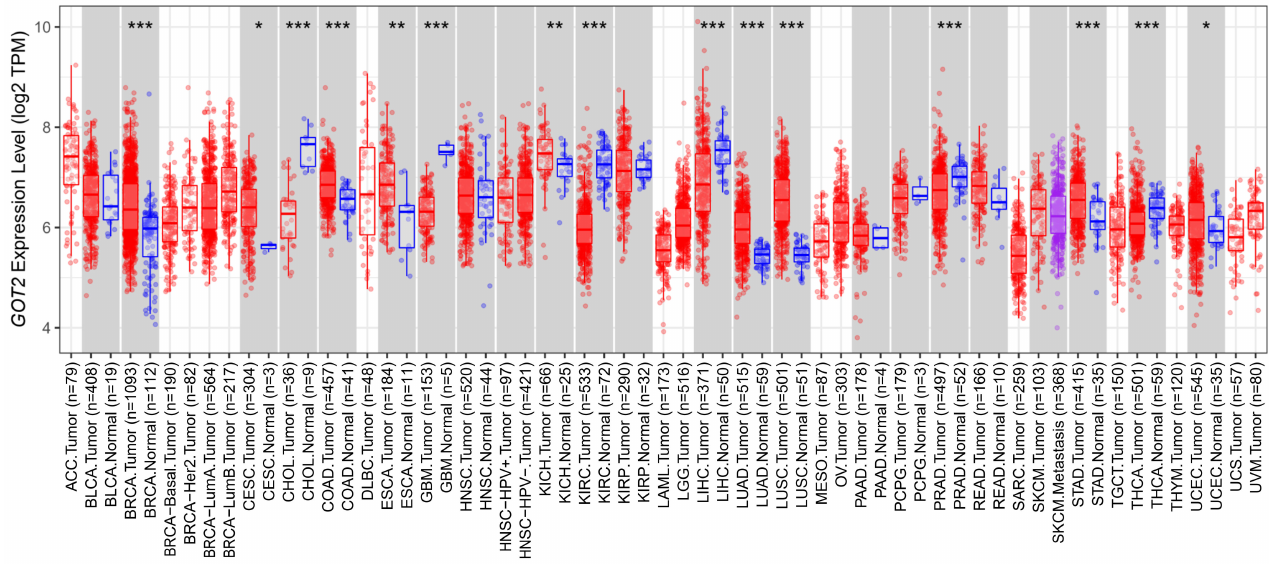
Figure 1. GOT2 expression levels in pan-cancer (TCGA dataset). The box plot comparing specific GOT2 expression in tumor samples (red plot) and paired normal tissues (blue plot) was derived from the TIMER database (* p < 0.05, ** p < 0.01, *** p < 0.001). TPM: transcripts per